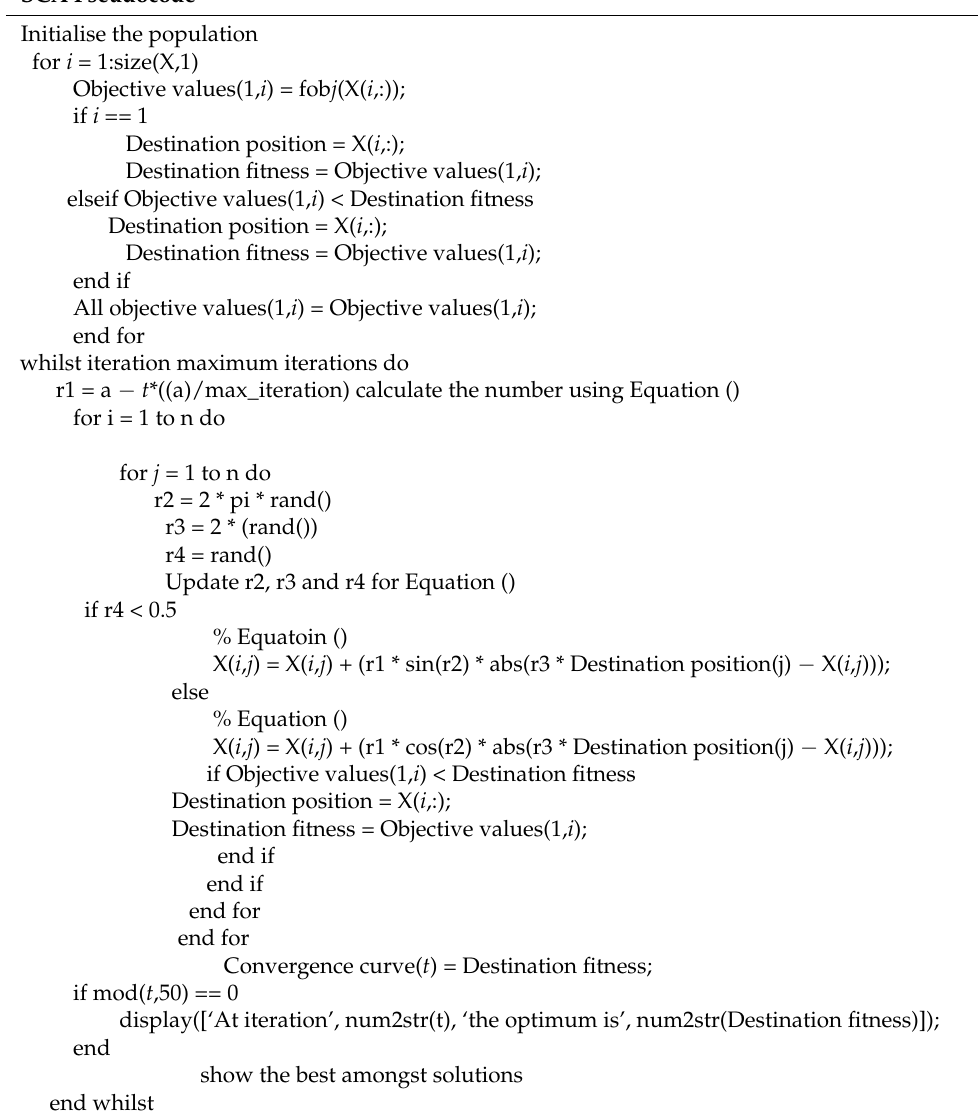
Table 1. Pseudocode of SCA. SCA